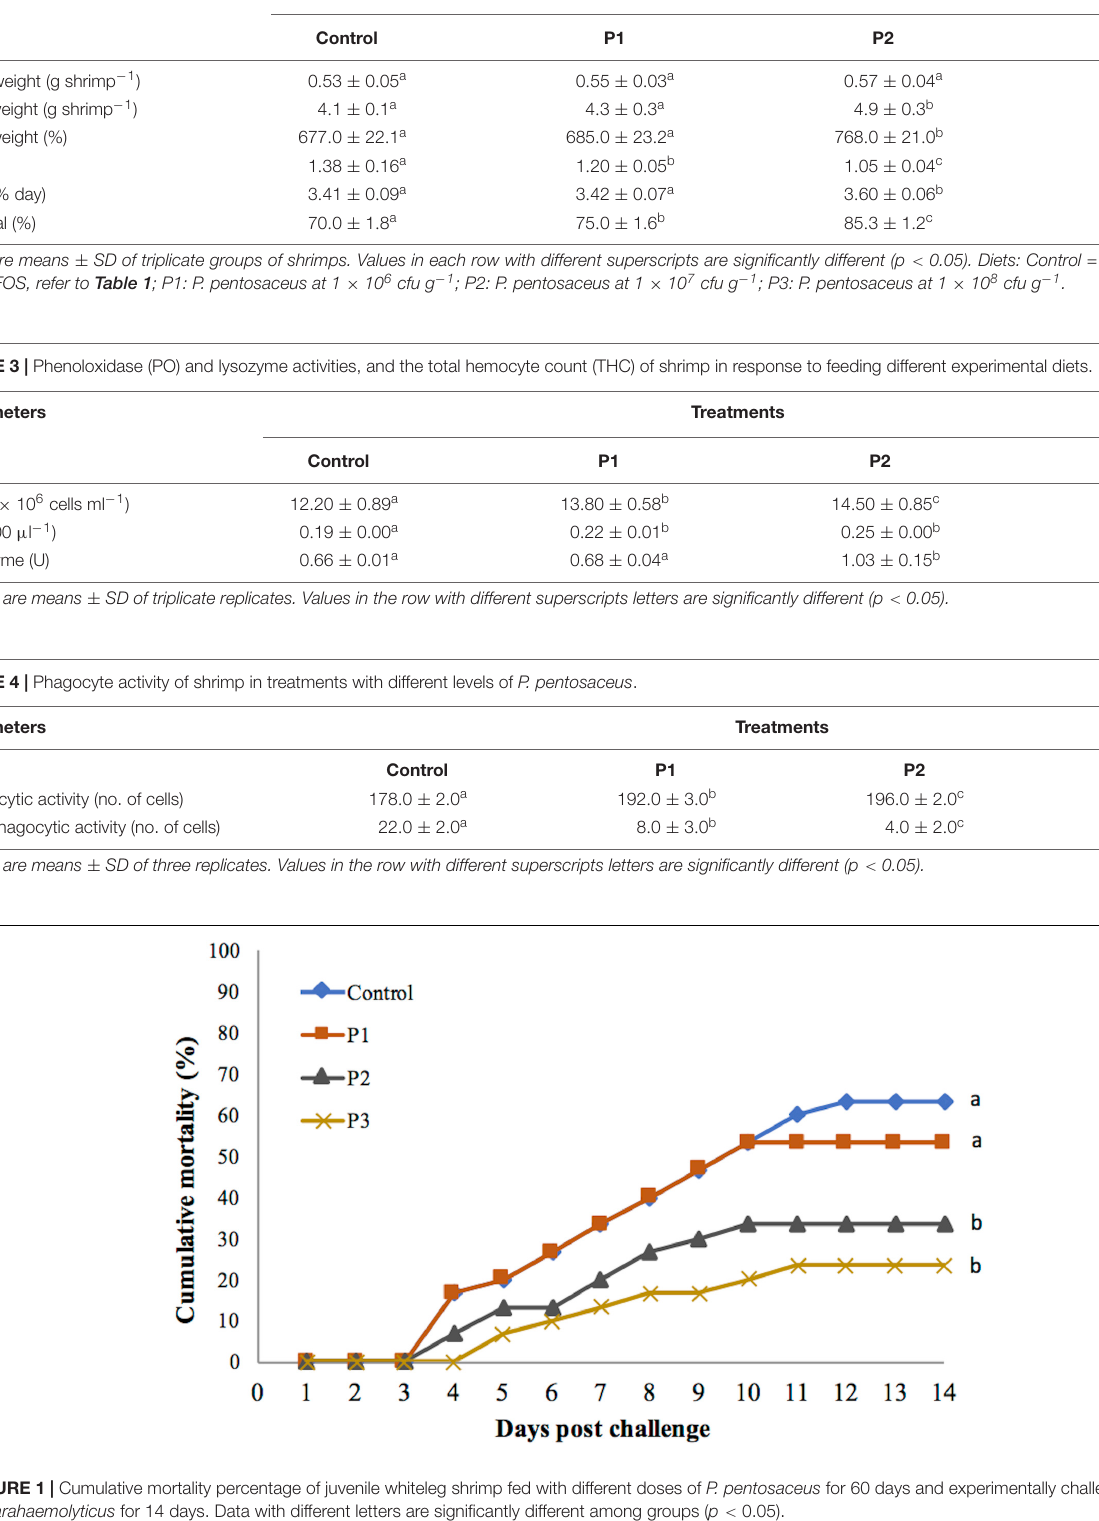
Frontiers in Microbiology |